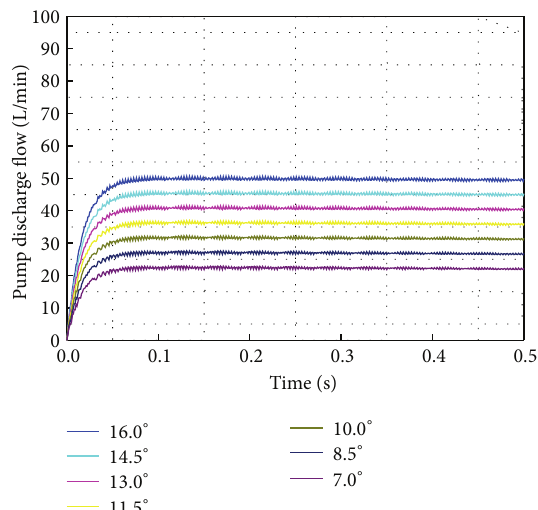
Figure 18: Simulation result of discharge flow ripple according to swash plate angle.